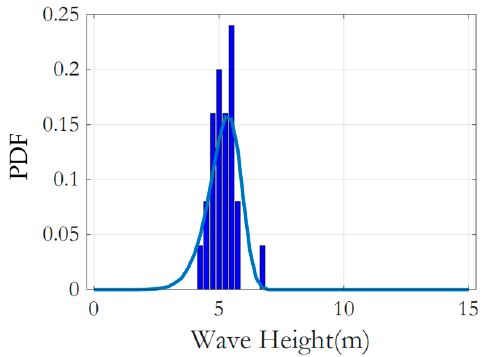
Figure 4. PDF of annual significant wave height ( 𝐻 (cid:3046) ) [27].